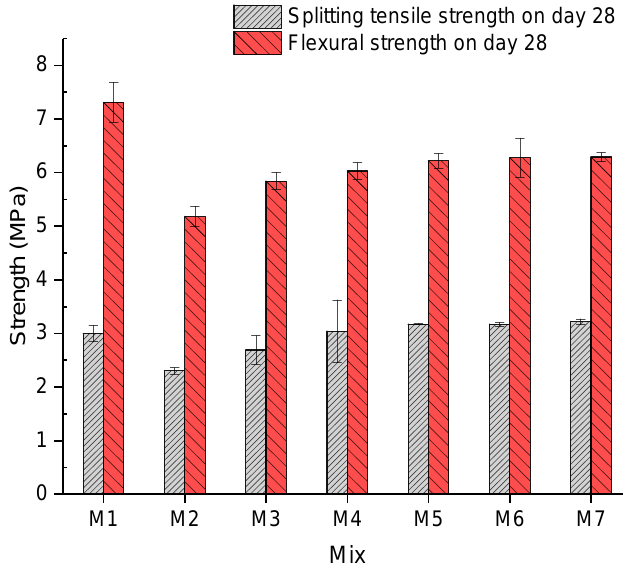
Figure 9. Splitting tensile and flexural strength.